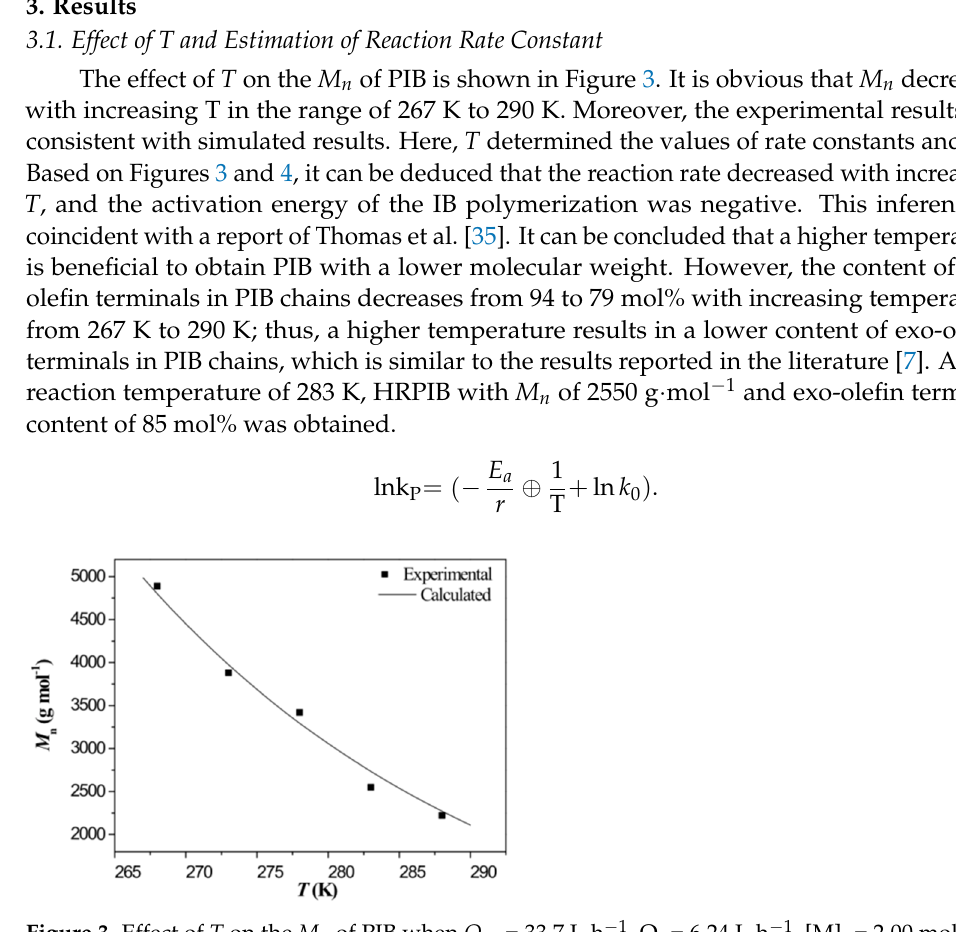
Figure 2. Simulation flow chart for the models.